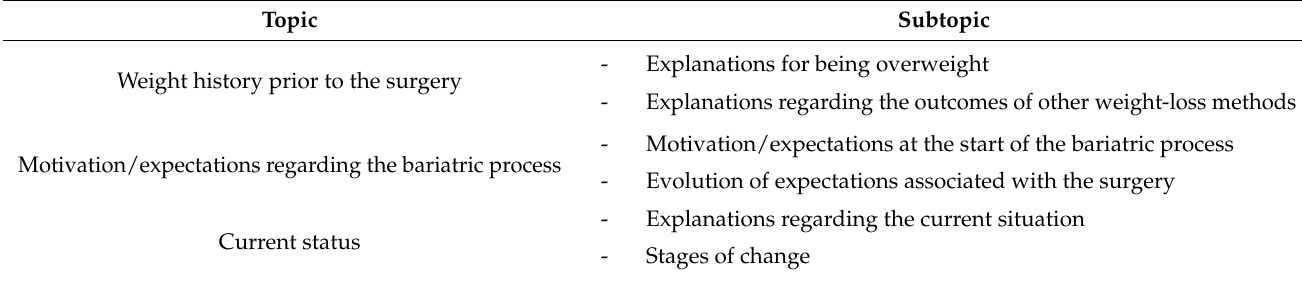
Table 6. Topics and subtopics